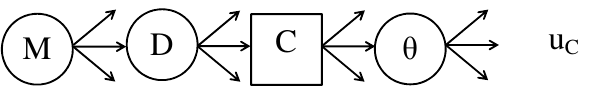
Figure 12. Manufacturer’s perception of the consumer’s decision